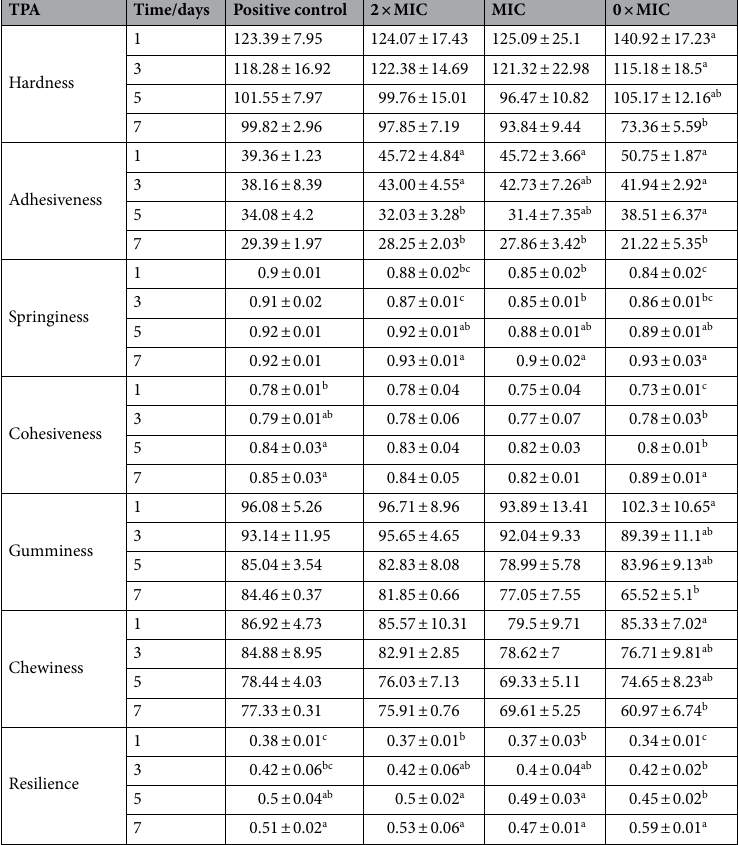
Table 3. Pork texture test results with PCA added at different storage times. Each value is expressed as mean ± standard deviation (n = 3). a–c Values with different letters in the same column are significantly different (P <